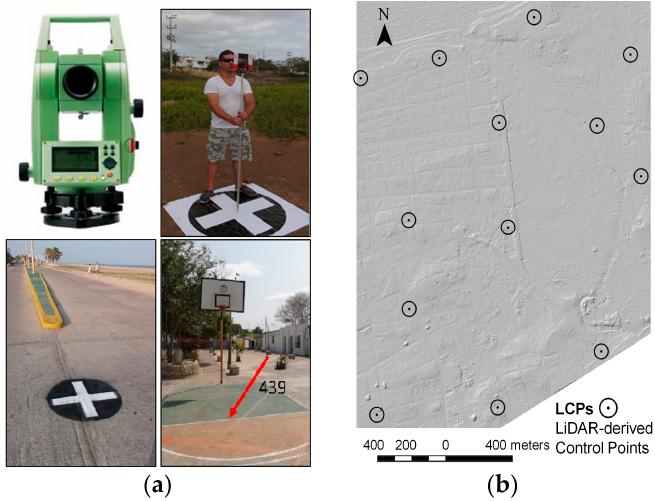
Figure 3. General methodology for ground control point (GCP) and LiDAR-derived control point (LCP) determination (method applied); ( a ) Leica TCR 403 total station used for GCP; ( b ) LiDAR DEM altimetric reference (displayed in shaded relief) with LCPs placed on study area.